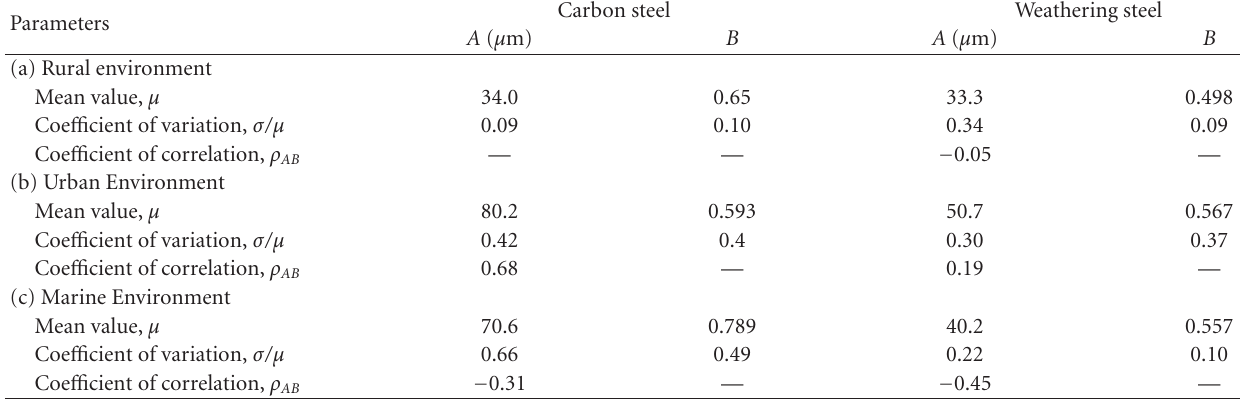
Table 1: Statistical parameters for A and B [5,